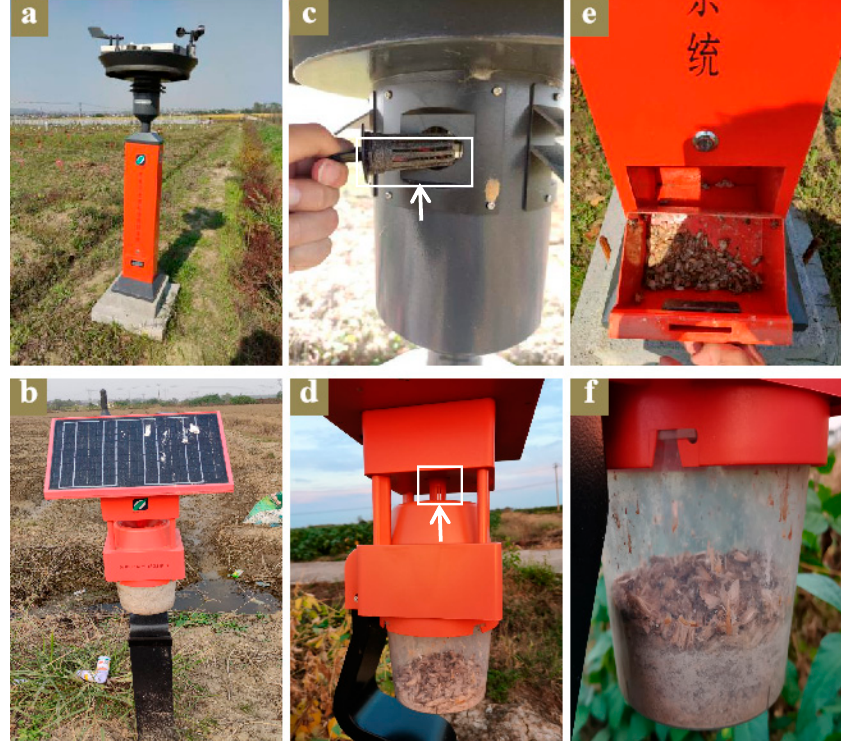
Figure 2. Two kinds of automatic insect monitors, installation positions of pheromone lure and their male collection devices. ( a ) AIM; ( b ) AIM-lite-A; ( c , d ) Installation device and location of pheromone lure (indicated by the white box and arrow in the figure) of AIM and AIM-lite-A, respectively; ( e , f ) insect collection device of AIM, AIM-lite-A and captured males of S. litura